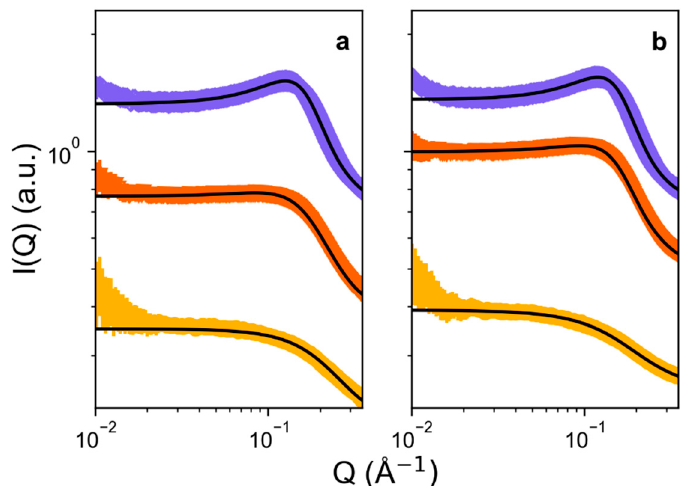
Figure 6. ( a ) SAXS of C 12 TAB (5, 10, and 15 wt.%) in 2-propethaline DES; ( b ) SAXS of C 12 TAB (5, 10, 15 wt.%) in 3-propethaline DES. Experimental surfactant concentrations are represented by yellow circles (5 wt.%), orange downwards triangles (10 wt.%), and purple diamonds (15 wt.%), and fits are shown as black lines. Data and fits are omitted where small-angle scattering could not be reliably fitted due to signal-to-noise ratio, i.e., for 2 wt.% samples of C 12 TAB.